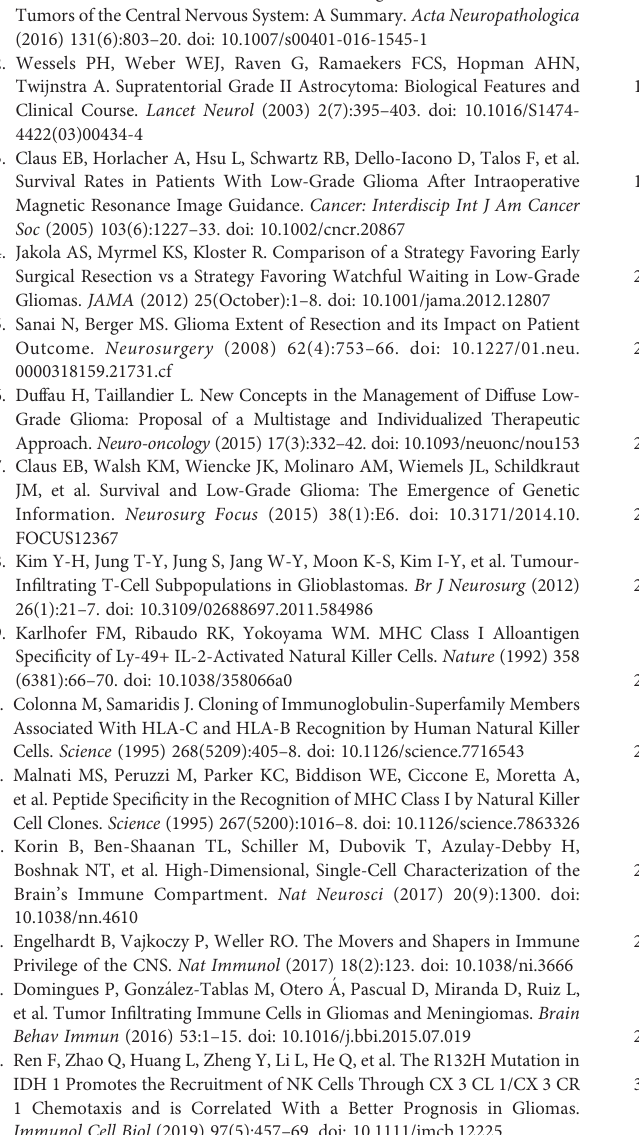
Supplementary Figure 4 | Kaplan-Meier curves of NK cell receptor family genes in LGG patients. Survival analysis of receptor genes CD226 (encoding DNAM-1), CD244 (encoding 2B4/SLAMF4) , CRTAM, KIR2DL4, NCR1 (encoding NKp46) and NCR3 (encoding NKp30) in TCGA-LGG. High expression of CD226 gene is signi fi cantly related to poor survival. Low (L) and high (H) expression groups were split by median TMM normalized counts. Statistics was performed by log-rank test. Supplementary Table 1 | Log rank p values and Benjamini-Hochberg corrected p values. Log rank p-values of Kaplan-Meier curves were all corrected by BH procedure (/ =